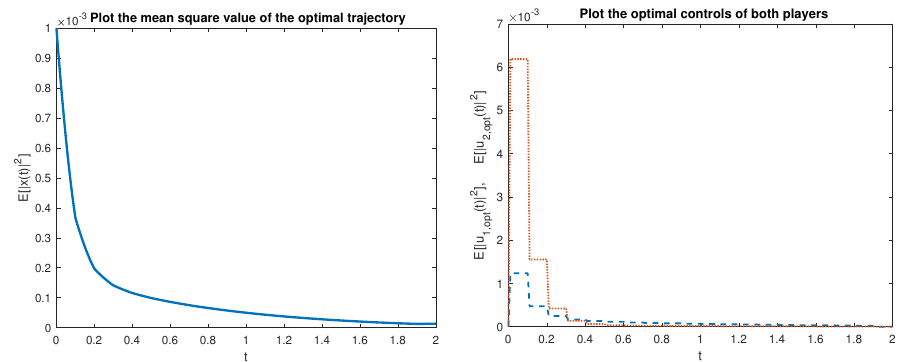
Figure 2. ( left ) E [ | ˜ x ( t ) | 2 ] ; Interval [ t 0 , τ ] = [ 0,2 ] ; ( right ) E [ | u 1, opt ( t ) | 2 ] and E [ | u 2, opt ( t ) | 2 ] ; Interval [ t ] = [ 0,2 ] 0 , τ